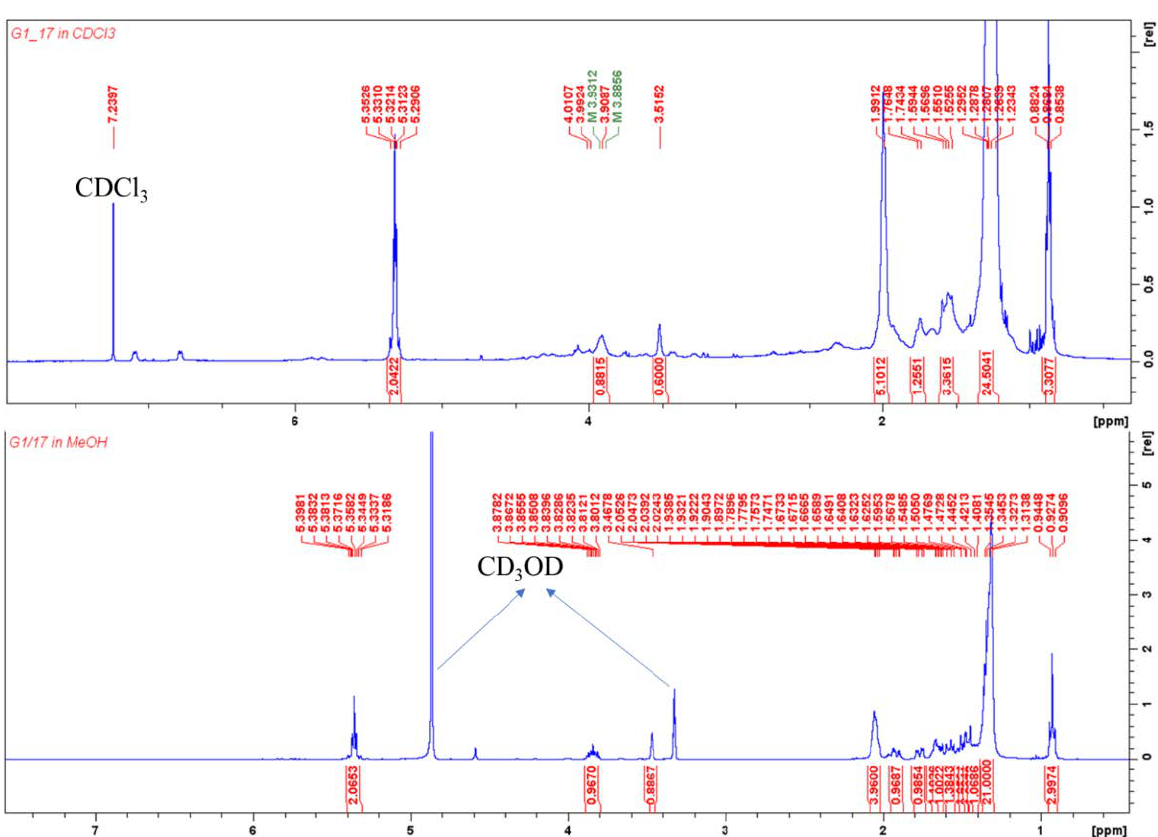
Figure 3. ECD spectra of compounds 2 , 3 and 4 .